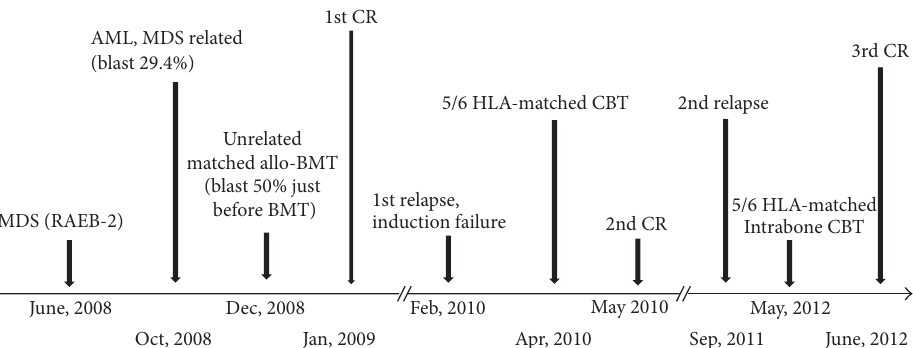
Figure 1: Time course of disease related to the HSCT. MDS, myelodysplastic syndrome; RAEB-2, refractory anemia with excess blast-2; allo-BMT, allogeneic bone marrow transplantation; CR, complete